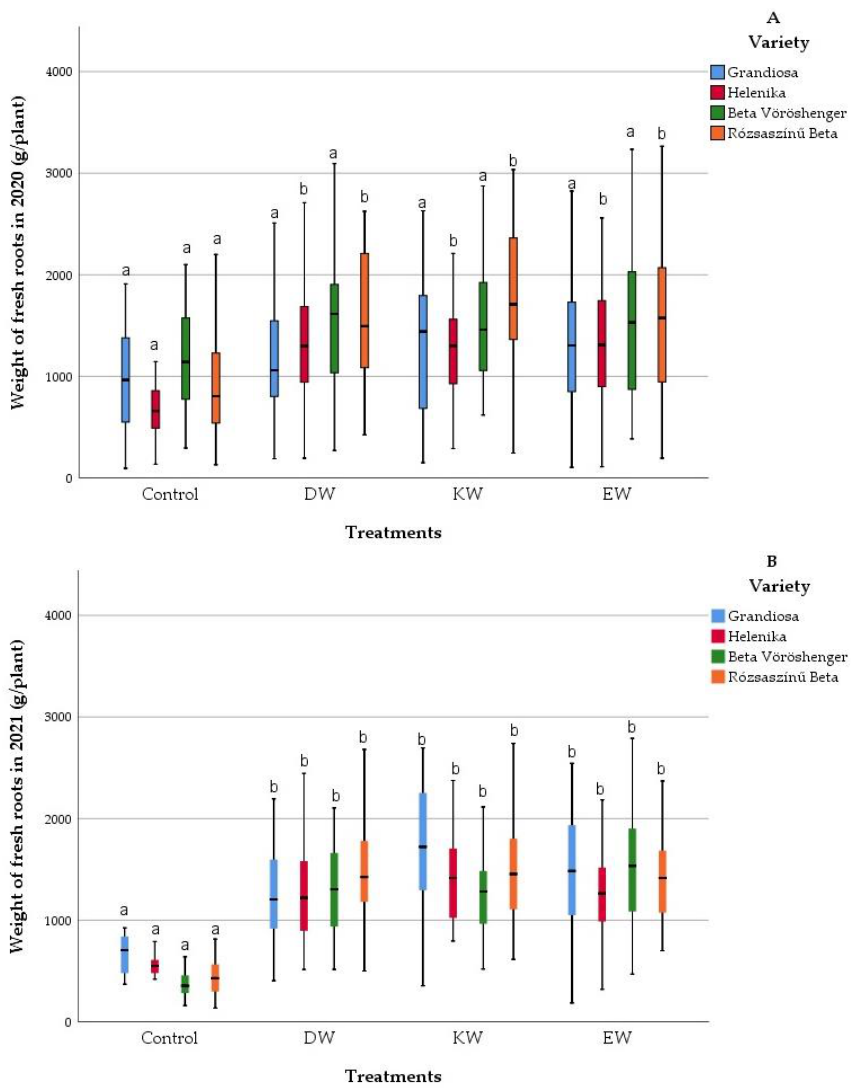
Figure 3. Mean fresh root weight of individual sugar and fodder beet plants in 2020 ( A ) and 2021 ( B ). The indexes with same letters means no significant differences between the treatments. N = 32.